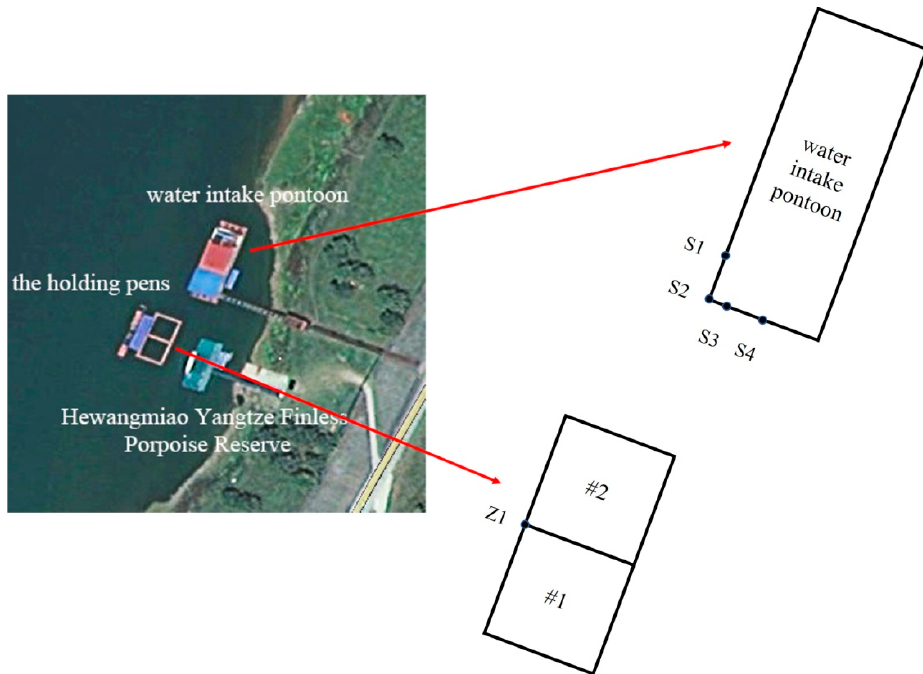
Figure 2. Sampling points (S1 to S4 were set up at the water intake pontoon; Z1 was set up at the holding pens).